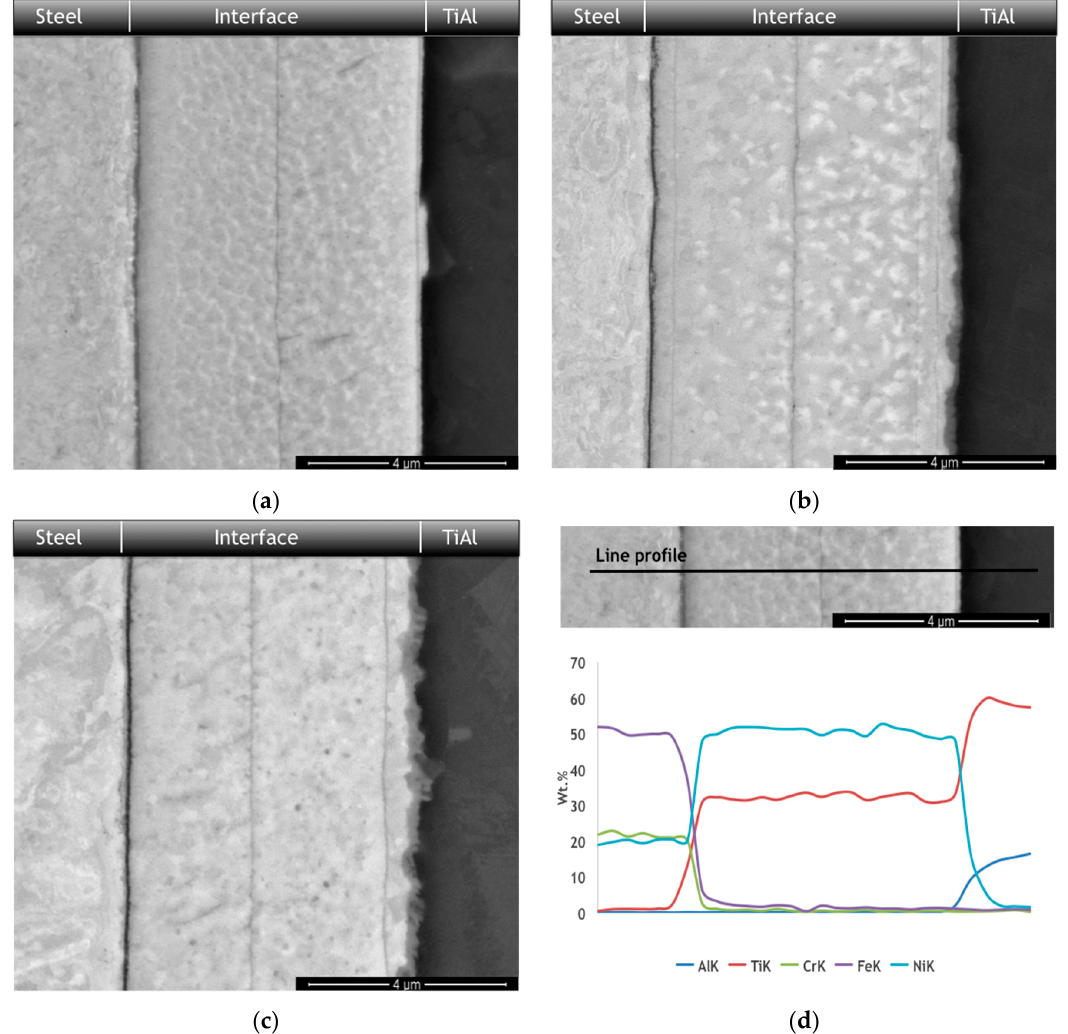
Figure 2. SEM images of the TiAl/steel joints produced at: ( a ) 700 °C under a pressure of 50 MPa using Ni/Ti multilayers with 30 nm of bilayer thickness; ( b ) 800 °C under a pressure of 10 MPa using Ni/Ti multilayers with 30 nm of bilayer thickness; ( c ) 800 °C under a pressure of 10 MPa using Ni/Ti multilayers with 60 nm of bilayer thickness and ( d ) EDS profile across the interface presented in ( a ).